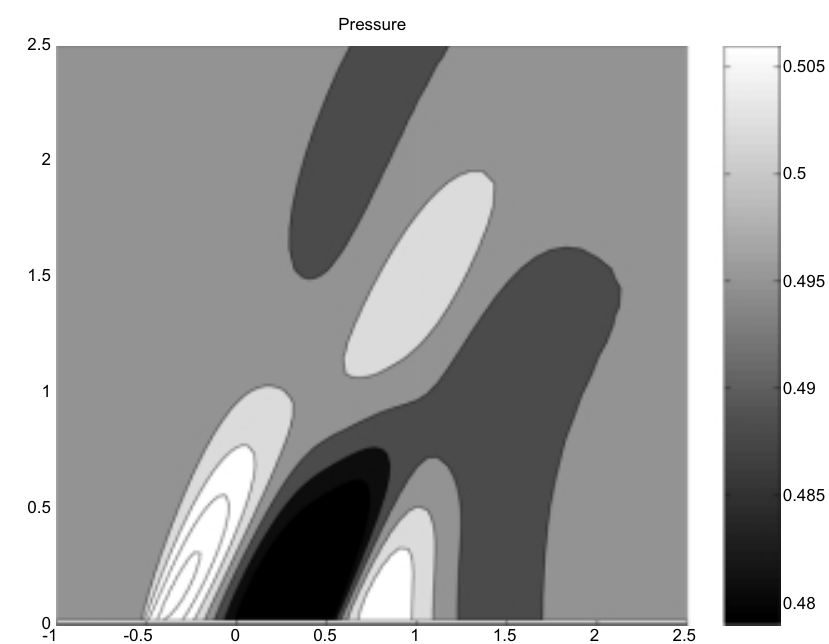
Fig. 22. Pressures after 20 second simulation using 12 modes with δ 1 = 0 . 01